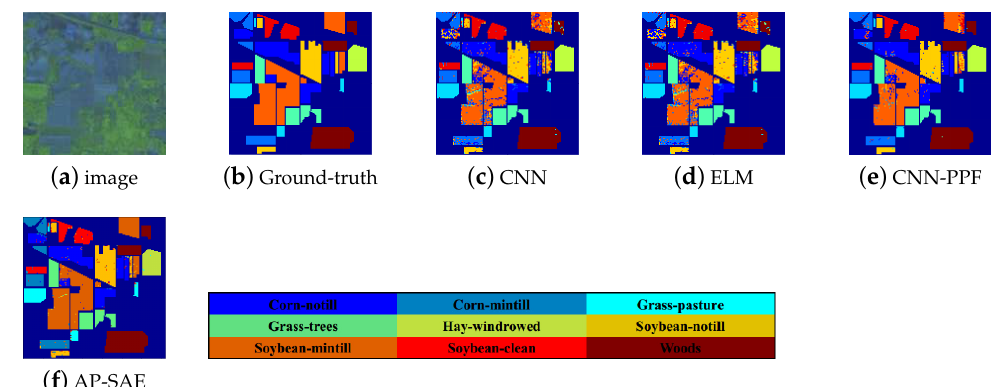
Figure 17. Classification result with 9 classes for the Indian Pines data set,as thematic